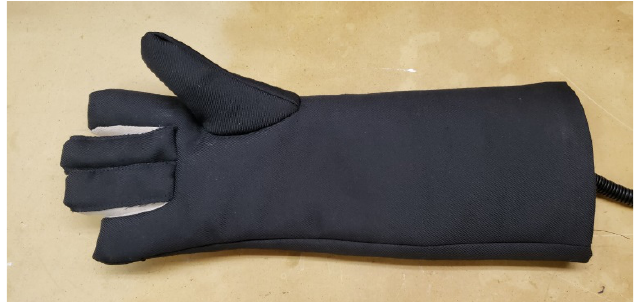
Figure 6. General construction of a prototype Active Textile glove with CNT inner liner. The glove has an outer protective layer, CNT center layer, and soft inner layer against the skin. The tube at the cuff is for air flow into the glove.